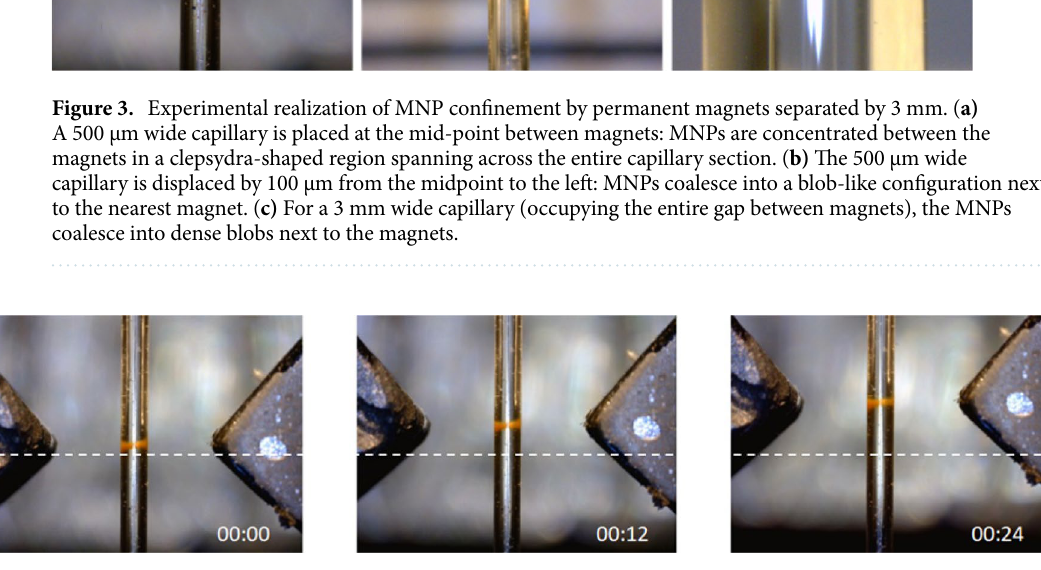
Figure 4. Dynamic behaviour of CSC. It solidly follows the magnets movement along the capillary while keeping its shape. Magnets speed: 60 µm/s; gap 3 mm; capillary 500 µm wide. For sake of clarity, a dashed line has been superimposed as a reference. Time is given in mm:ss format and 00:00 corresponds to initial magnets position after CSC